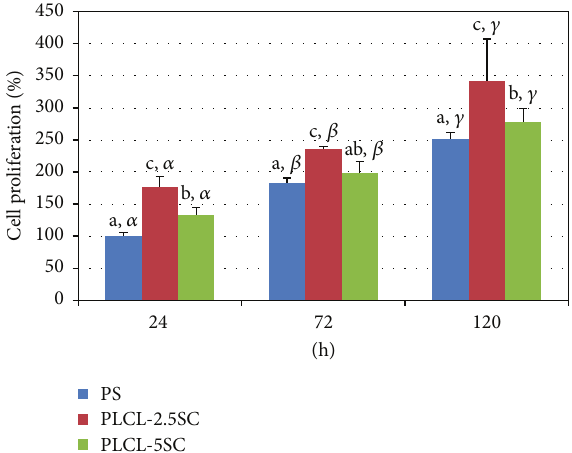
Figure 11: Percentages of cell proliferation of BCP-K1 on PLCL- 2.5SC and PLCL-5SC membranes, evaluated by calculating the OD 570 values from MTT assay, compared to the PS surface at 24 hours. All data presented are in mean ± SD format. Statistical difference is indicated by lowercase letters (a, b, c, and d) for each membrane on the same day. The symbols 𝛼 , 𝛽 , and 𝛾 indicate the difference between each day of the same membrane ( 𝑝 ≤ 0.05